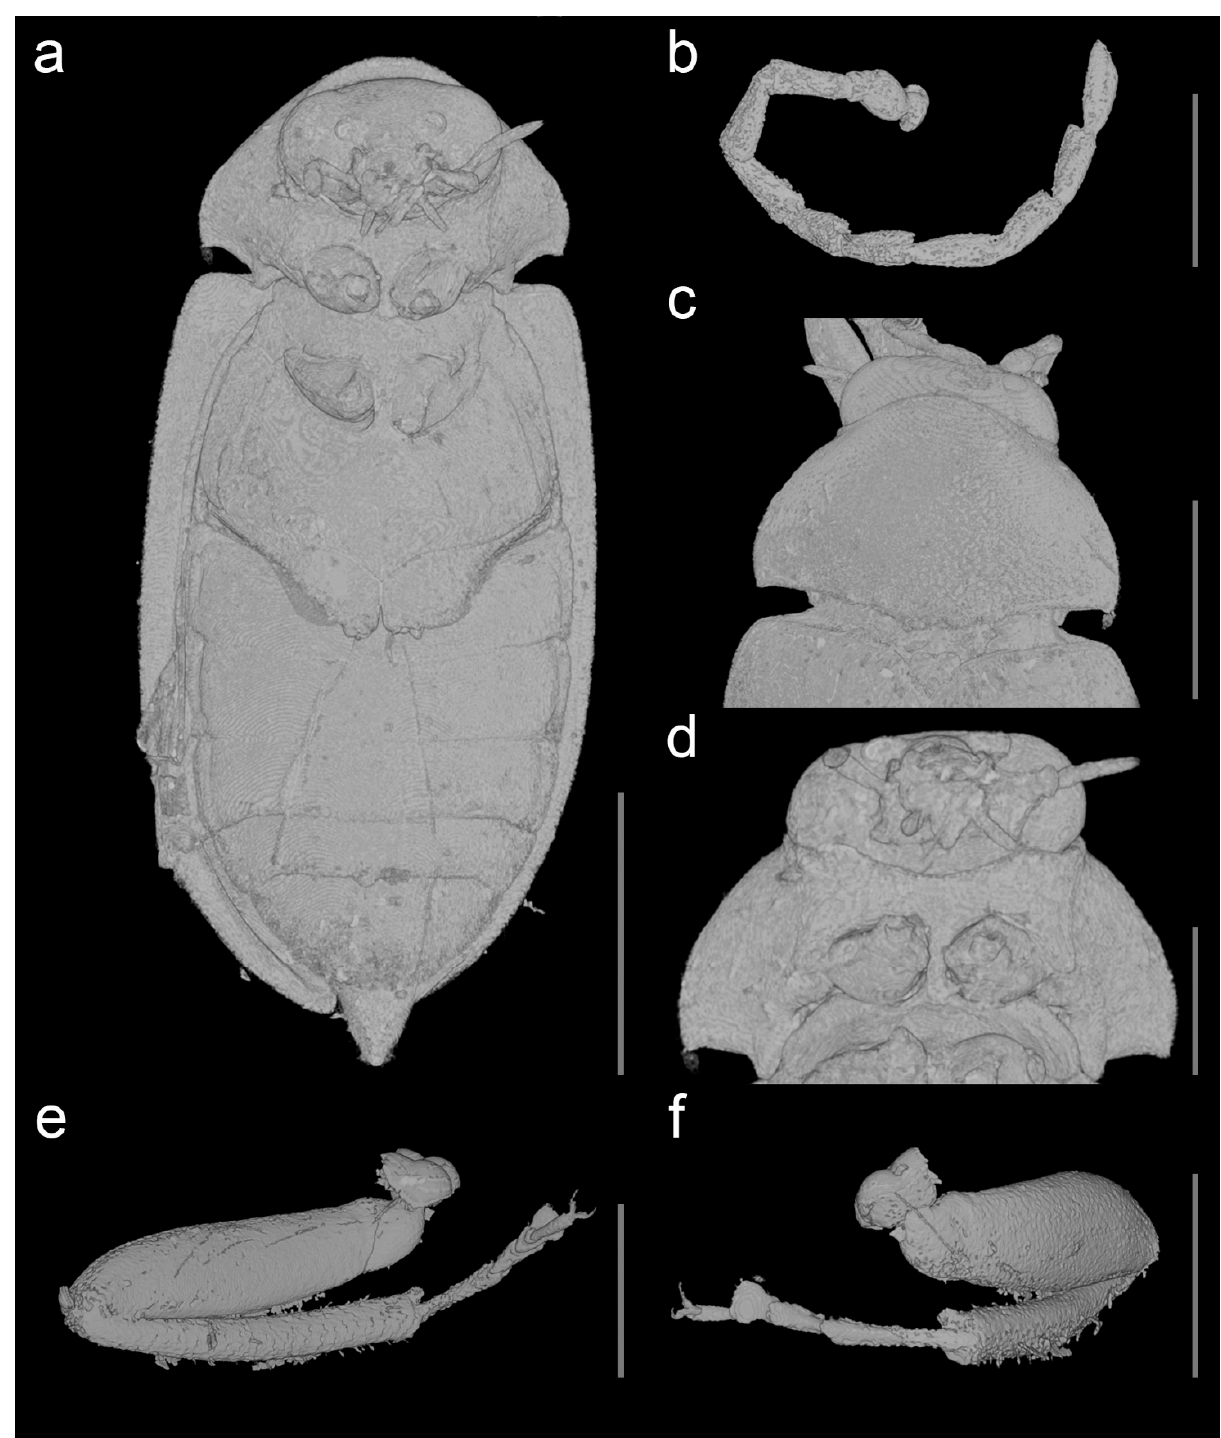
Figure 5. Ptilodactyla eocenica Kundrata, Bukejs and Blank, sp. nov., details of morphology. ( a ) Habitus, ventral view; ( b ) antenna, lateral view; ( c ) habitus, pronotum, and scutellar shield; ( d ) habitus, prosternum; ( e , f ) mesolegs. Scale bars = ( a ) 3.0 mm; ( b , d – f ) 1.0 mm; ( c ) 2.0 mm.